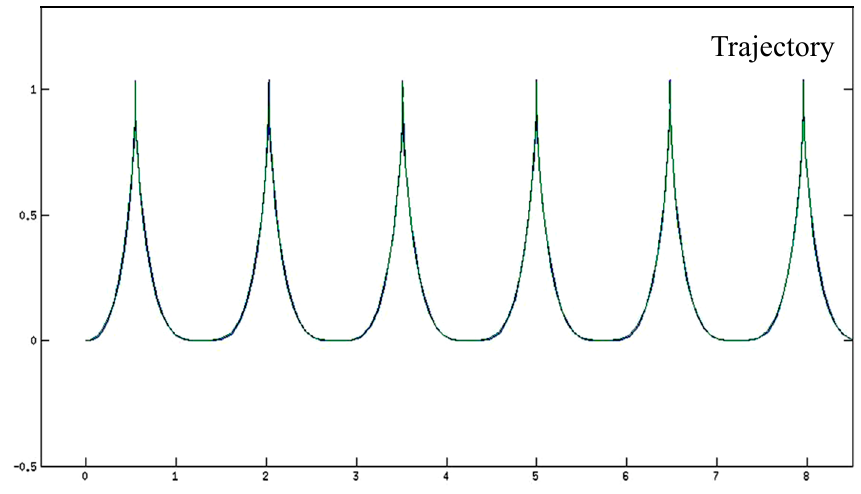
Figure 12. Trajectory to be followed by robot.